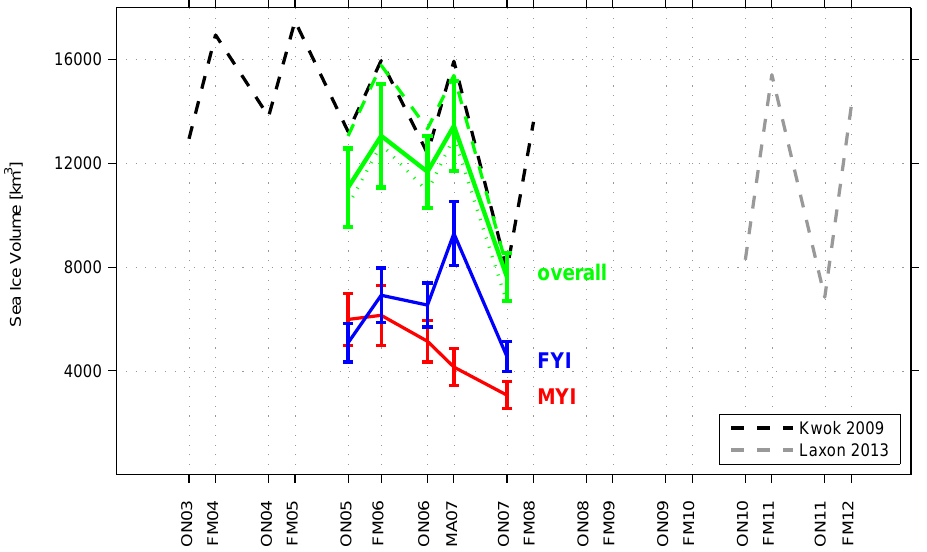
Fig. 8. Sea ice volume and its uncertainties calculated with different methods. For comparison ICESat results based on sea ice thickness data from JPL are included as a black dashed line, and CryoSat-2 values (Laxon et al., 2013) as the grey dashed line.